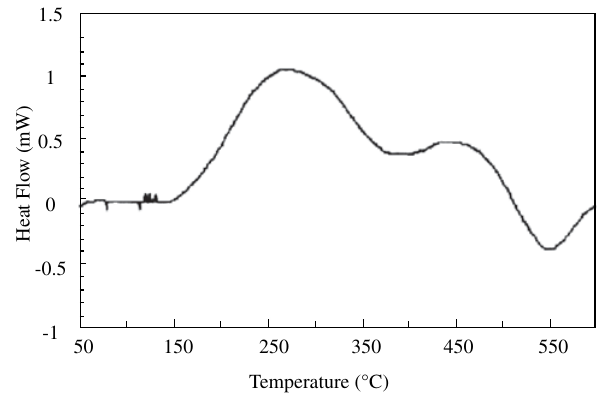
Figure 8. Scanning electron micrograph of Cu-13Al-2Nb milled for 12 hours with a lubricant.